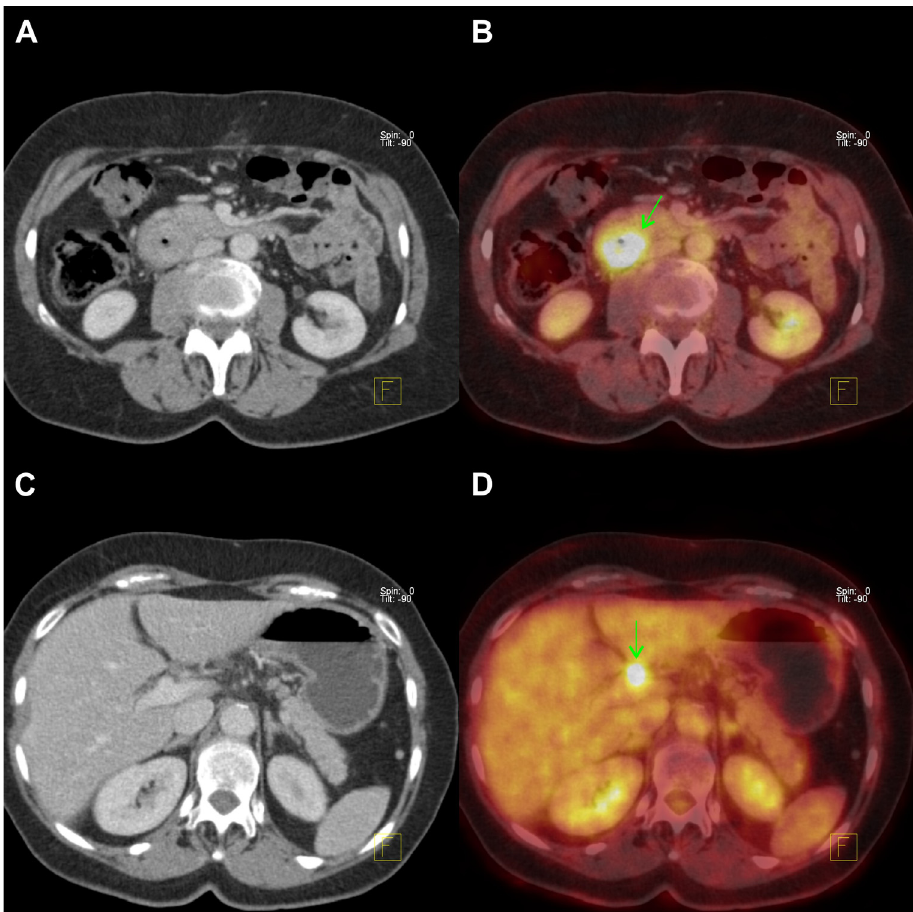
Fig. 4A. CT scan - circular duodenum wall thickening 4B. PET/CT fusion - FDG uptake in the duodenum wall 4C. CT scan - enlarged liver hilum lymph node 4D. PET/CT fusion - FDG uptake in liver hilum lymph